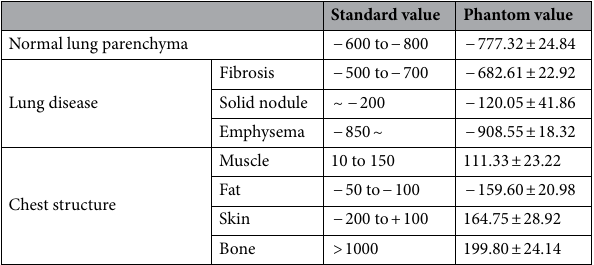
Table 3. Comparison of the HU values between the CT image and 3D-printed phantom 21,22 .